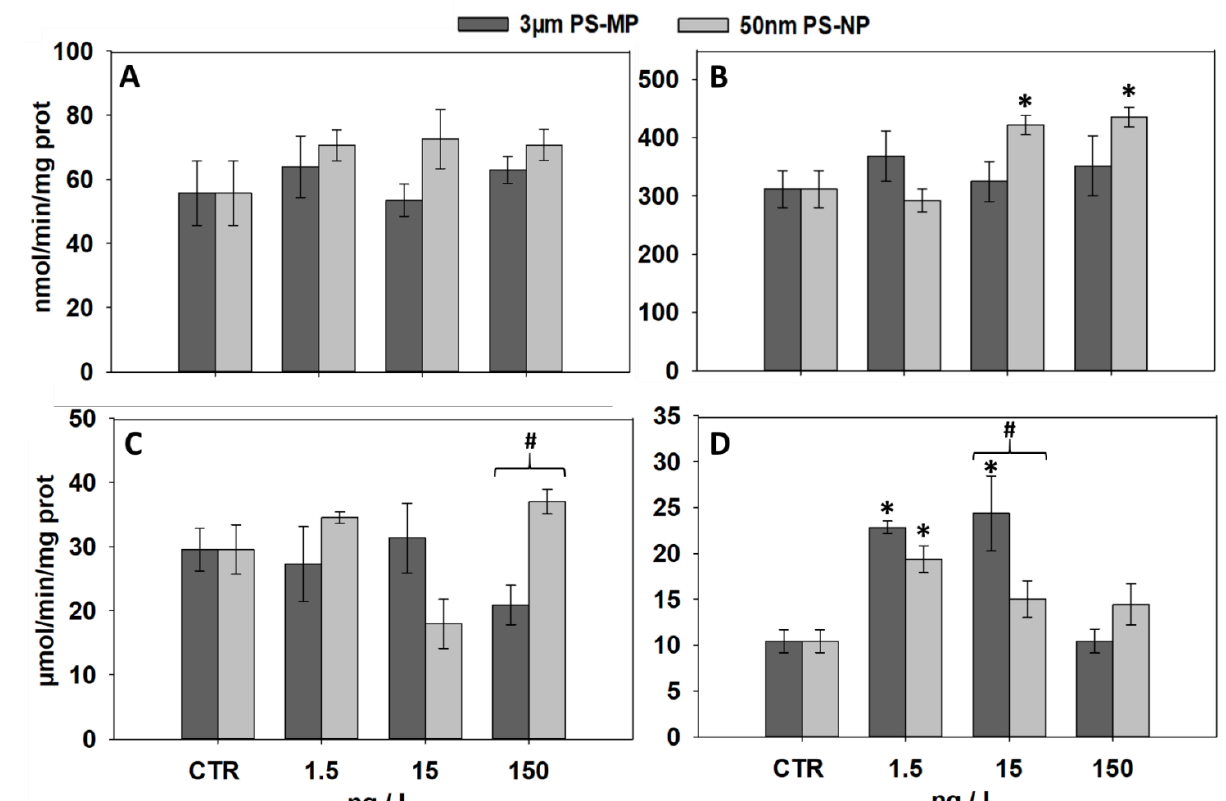
Figure 3. Activity of antioxidant/detoxification enzymes (mean ± SEM, N = 3) analyzed in mussels after 21 days of exposure to PS-MP and PS-NP; ( A , B ), glutathione S-transferase (GST) activity in mussel digestive gland ( A ) and gills ( B ); ( C , D ), catalase (CAT) activity in mussel digestive gland ( C ) and gills ( D ); *, significant ( p < 0.05) differences compared to control samples (CTR); #, significant differences ( p < 0.05) between PS-MP and PS-NP treatments.